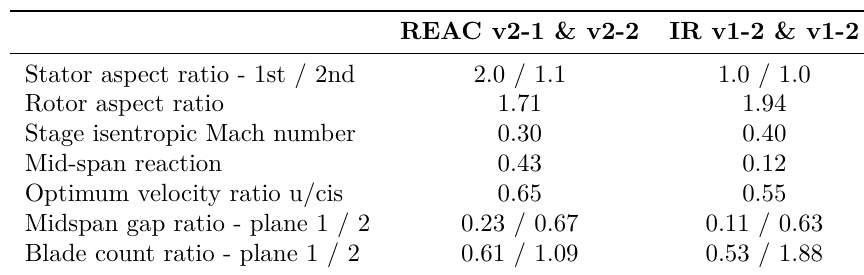
Table 1. The turbine stage geometry and operational regime parameters.